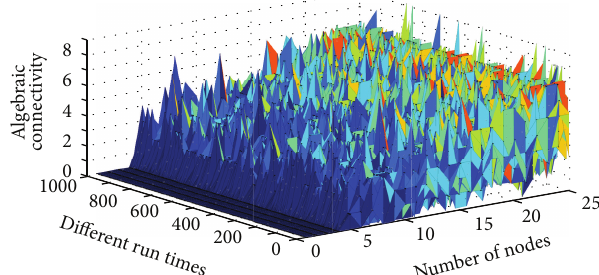
Figure 7: The relationship between throughput of network and